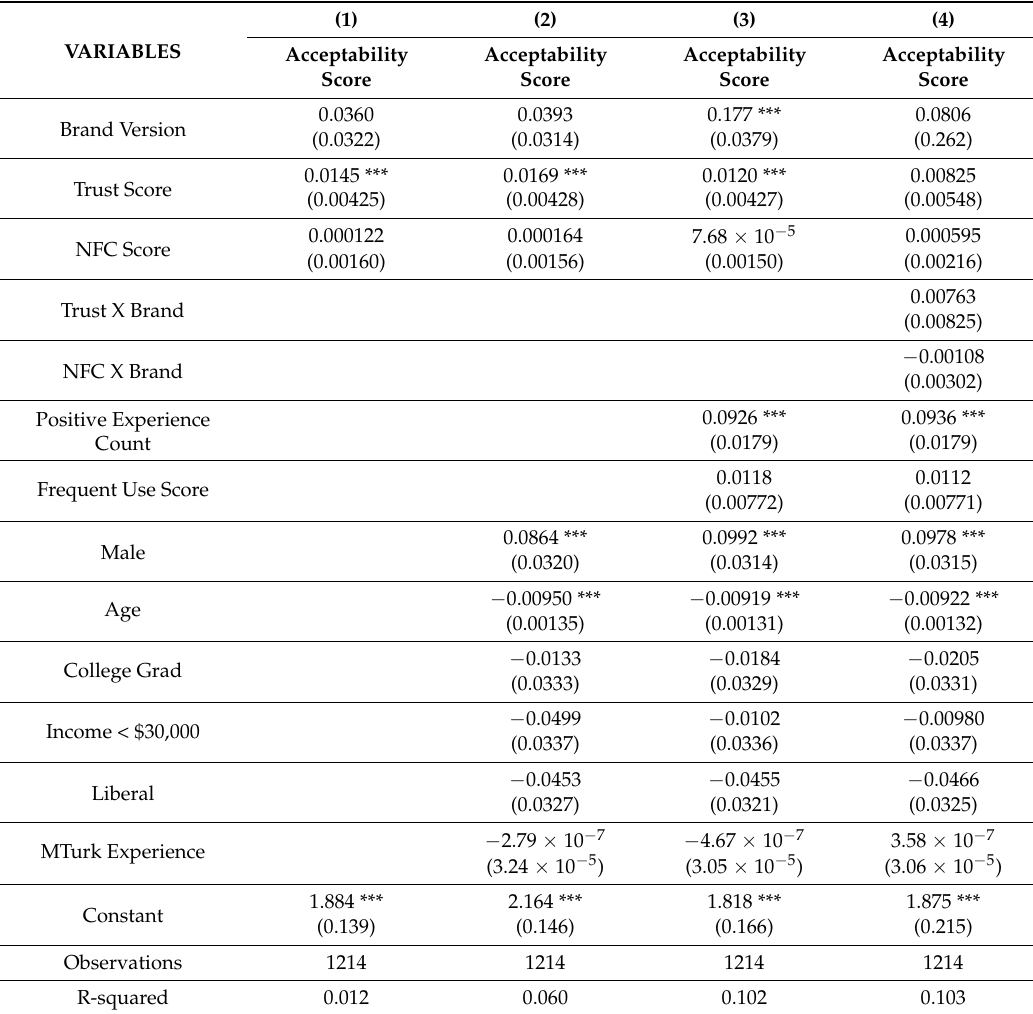
Table 5. Ordinary least squares regressions for all scenarios, with brand scenarios and generic scenarios merged.